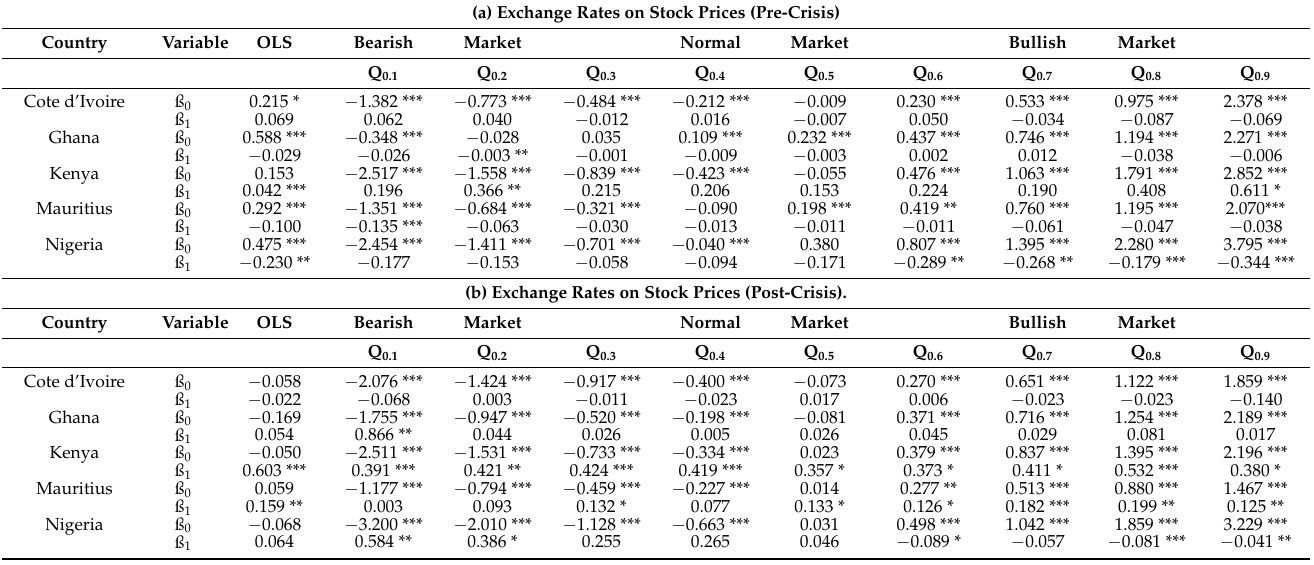
Table 13. Effects of ( a ) exchange rates on stock prices (pre-crisis) and ( b ) exchange rates on stock prices (post-crisis). (a) Exchange Rates on Stock Prices (Pre-Crisis)